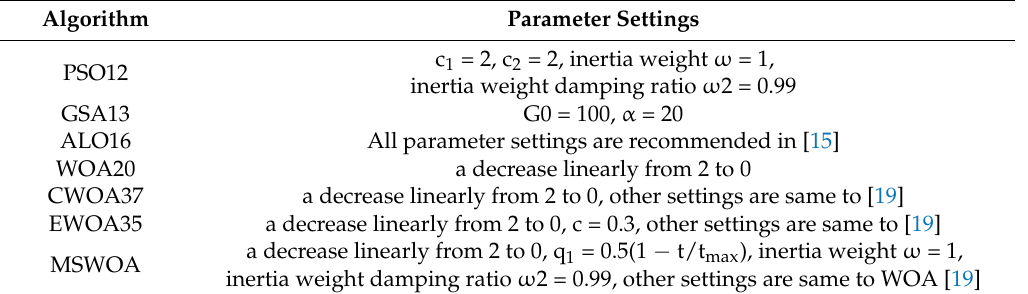
Table 5. Parameter settings for all algorithms in